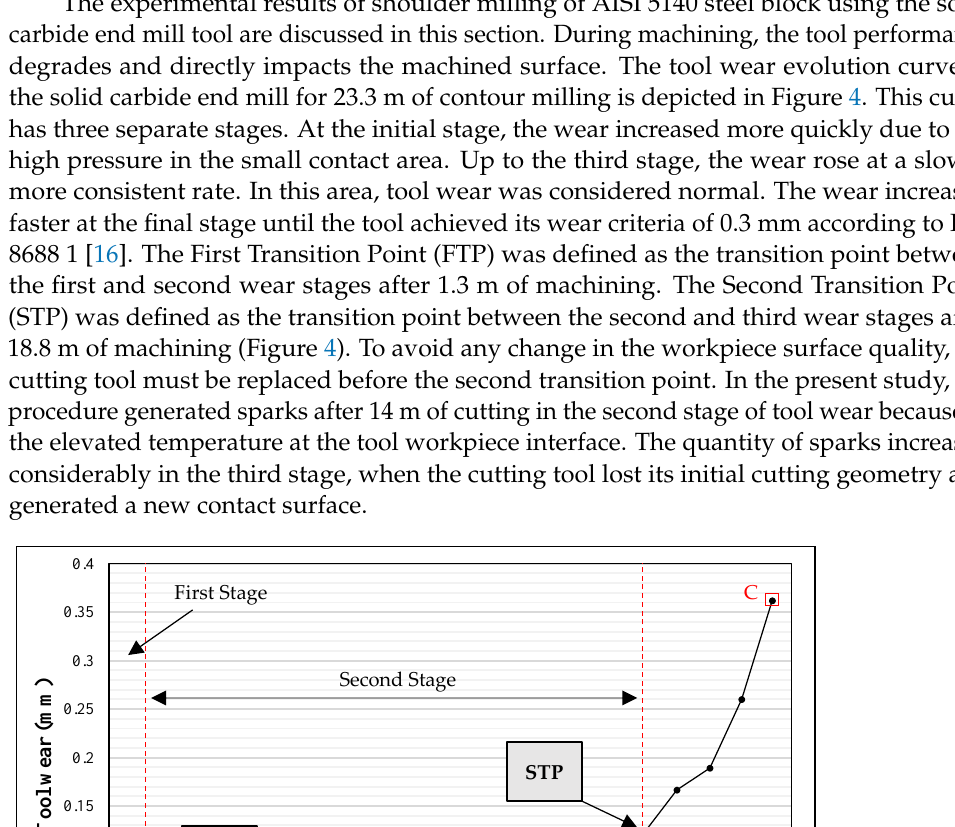
Figure 5. Areal surface roughness parameter ( 𝑆 𝑎 ) as a function of cutting length.